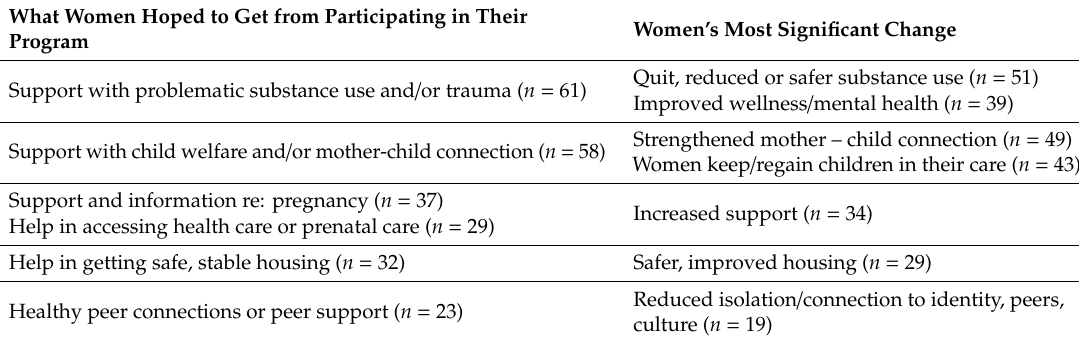
Table 4. Top themes in relation to what women hoped to get from participating in their program and their most significant